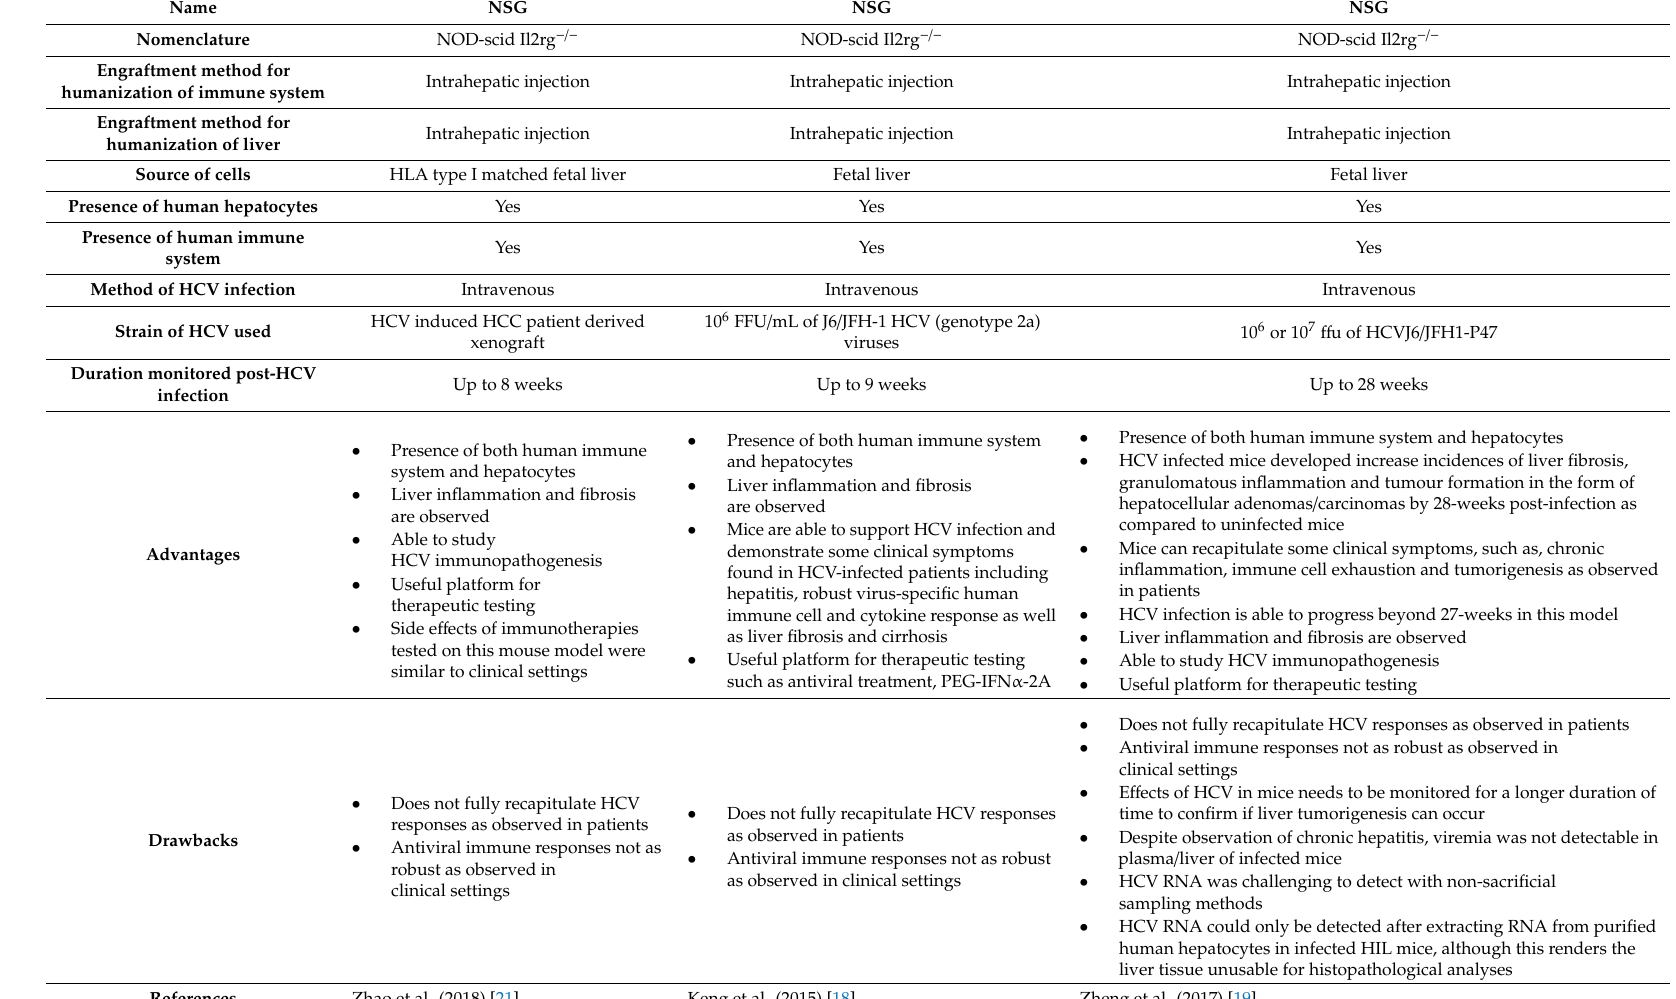
Table 4. Humanized mouse models with both human immune system and hepatocytes (HIL